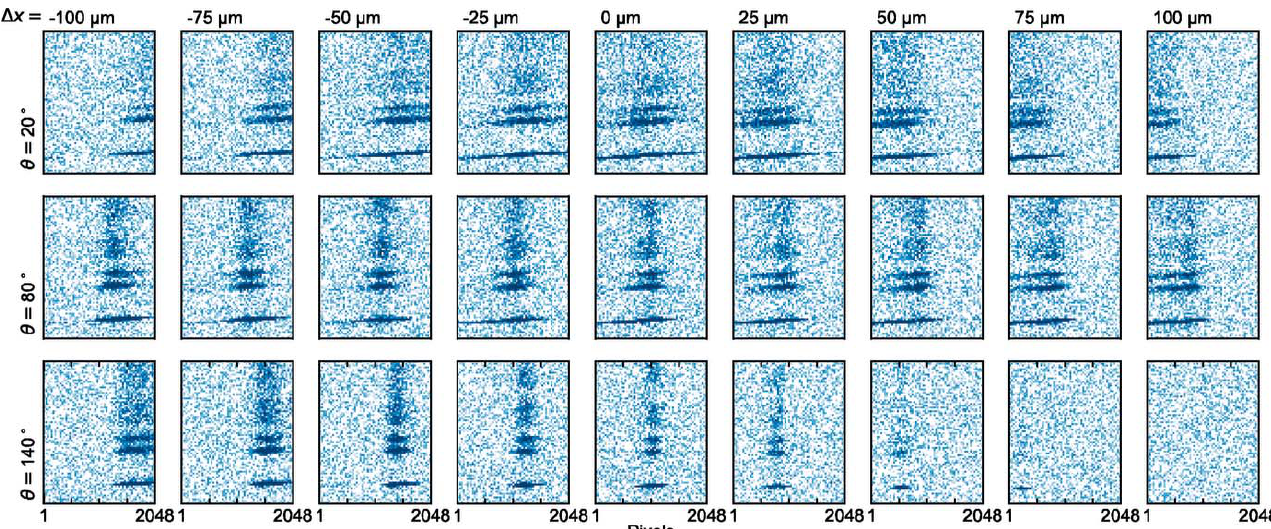
Figure 14 Panels showing the movement of the RIXS signal on an Andor CCD detector for different X-ray incident angles ( (cid:7) ) and sample x positions. The top, middle and bottom rows correspond to (cid:7) = 20 (cid:3) , 80 (cid:3) and 140 (cid:3) , respectively. The panels in each column correspond to increments of x in steps of 25 m m in negative or positive directions from the central position.